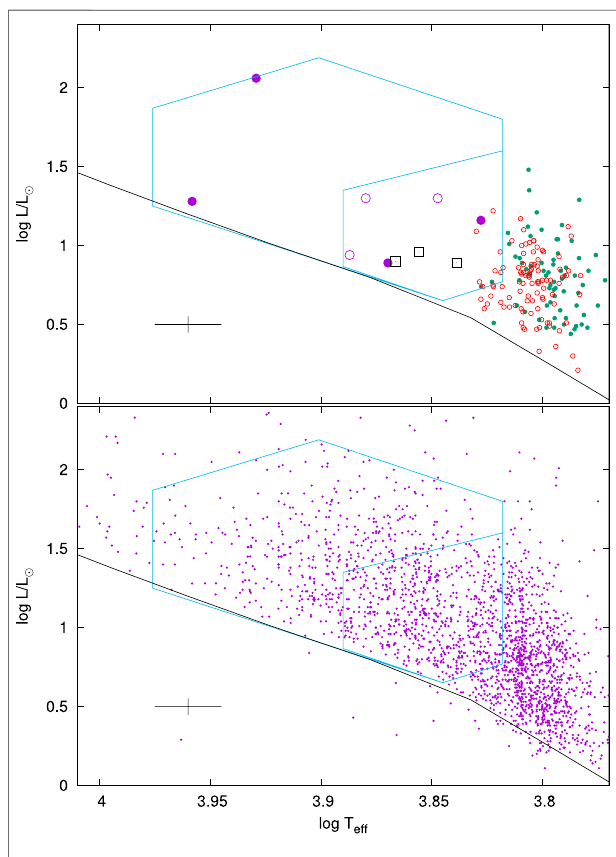
FIGURE 5 | Top panel: the location in the H – R diagram of stars in Tables1 – 3 .Newlydetectedstarsareshownbythesmall fi lledgreencirclesand knownstarsbysmallopenredcircles.Thelargesymbolsarestarswithpossible solar-like oscillations: violet fi lled circles — non-variable stars; violet open circles: δ Sct; black squares — c Dor stars. Bottom panel: the small fi lled circles are fromthe sample of2,347 stars used tosearch for solar-like oscillations. The zero-agemainsequenceformodelsofsolarabundancefromBertellietal.(2008) isshown(blacksolidline).Thelargepolygonalregionshowsthelocationof δ Sct stars from Balona (2018). The smaller polygon shows the location of the c Dor stars. The cross at bottom left shows 1 − σ error